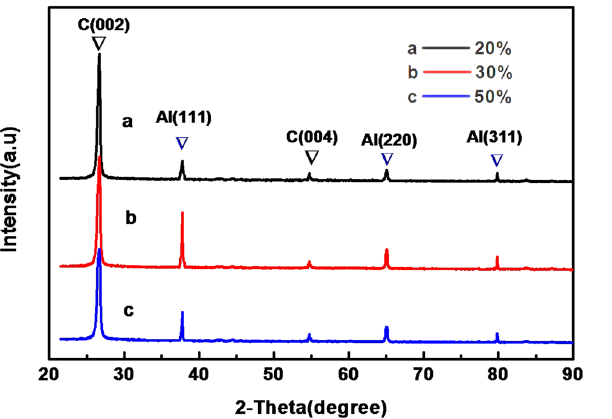
Figure 5: Electrochemical impedance spectra of C@Al – EG compo - sites with di ff erent Al contents after 100 cycles.